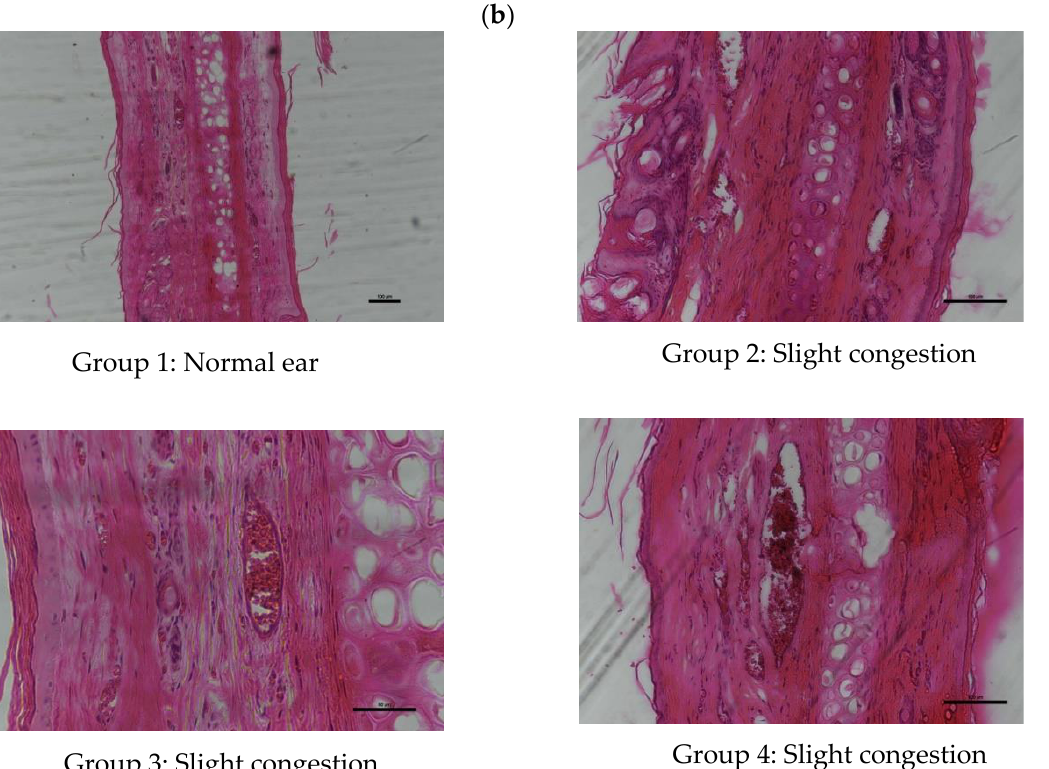
Figure 4. Effect of adjuvanted, sonicated antigens on hypersensitivity in rabbits. ( a ) Ear thickness (mm). ( b ) Ear hypersensitivity to antigen. ( c ) Histopathological changes in ear [Scale bar 100 μm]. Ear thickness increased significantly ( p < 0.05) in all groups from day 0 to day 14 followed by significant ( p < 0.05) decrease from day 14 to day 28 except for a non-signifi- cant ( p ≥ 0.05) decrease in Group 3 from day 21 to day 28.